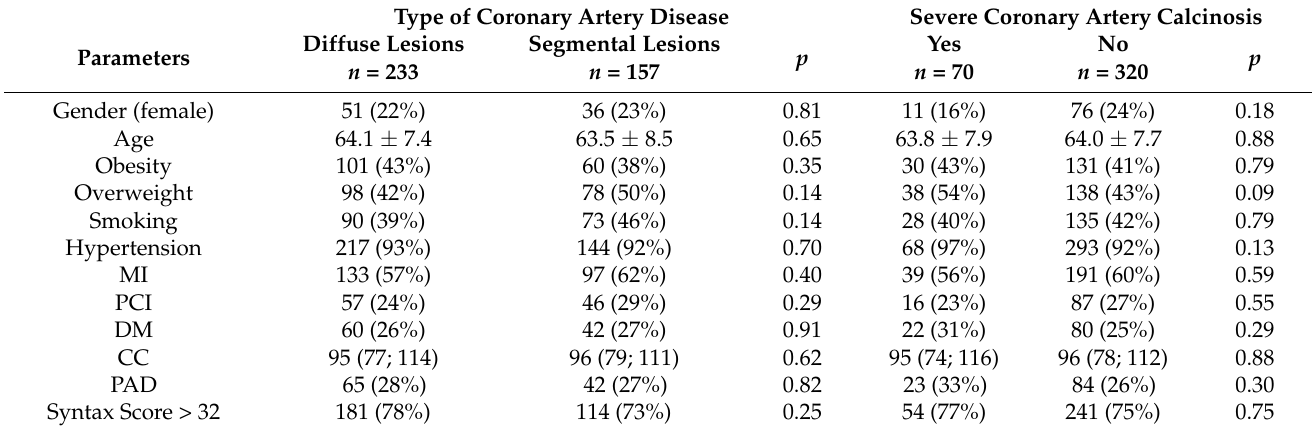
Table 1. Demographics in patients with diffuse or segmental lesions and with or without coronary artery